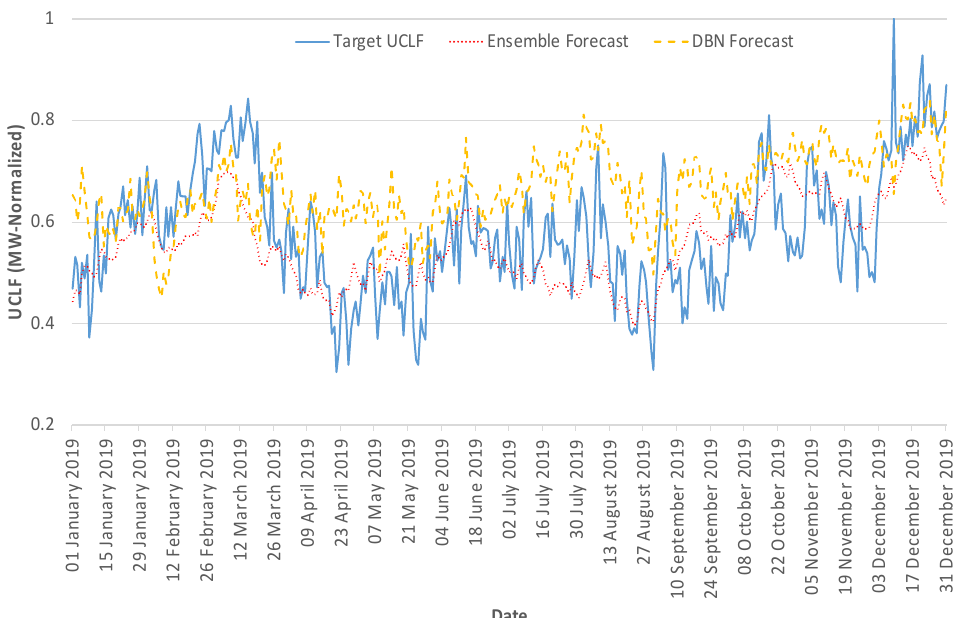
Figure 10. A plot of the DBN and ensemble lowest error model year-ahead UCLF forecast against the target UCLF.